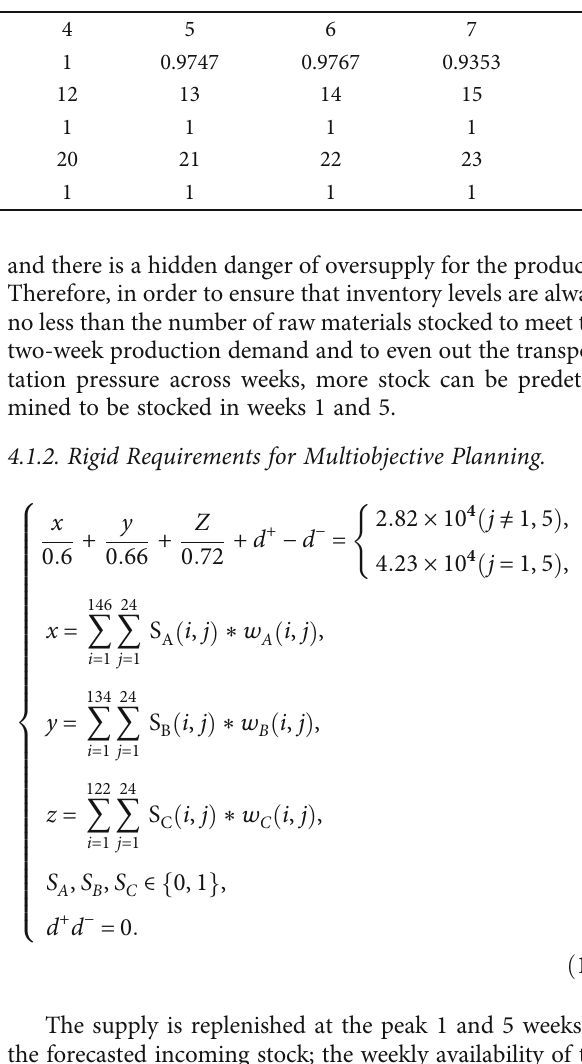
Table 1: The manufacturer ’ s material utilization rate for next 24 weeks.